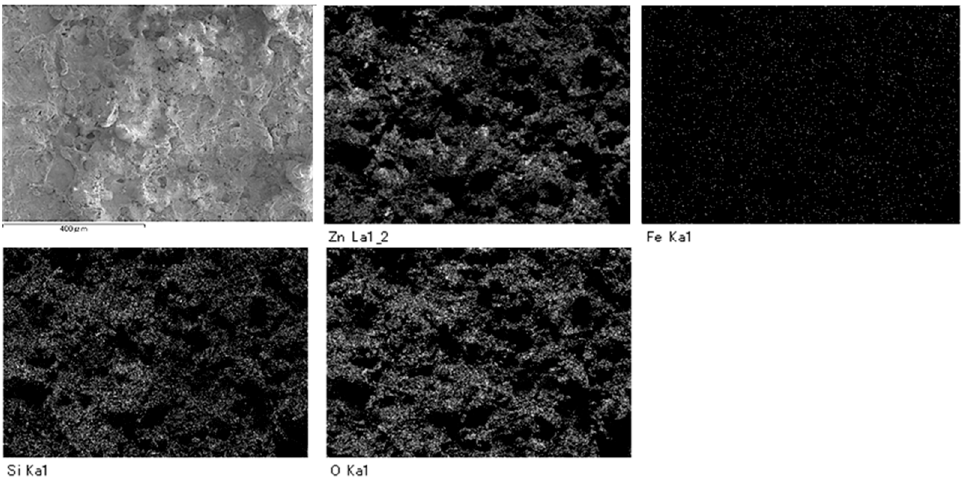
Figure 14. Element mapping images of the Zn-coated coupons after LBR-immersion testing exposure testing in water.